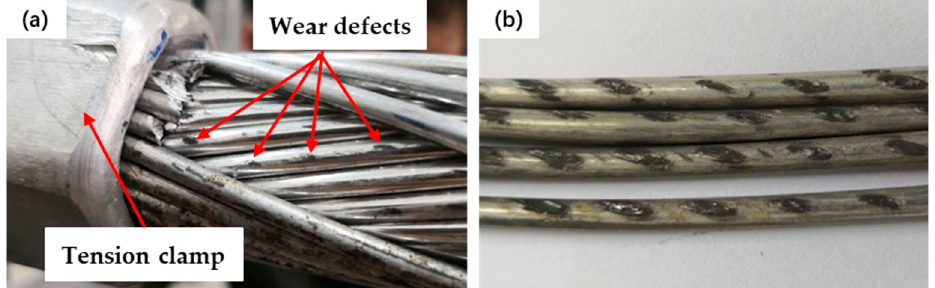
Figure 11. ( a ) Wear defects on the surface of the third layer of conductor, and ( b ) wear defects of the third layer of conductor at the outlet of the tension clamp after cutting.